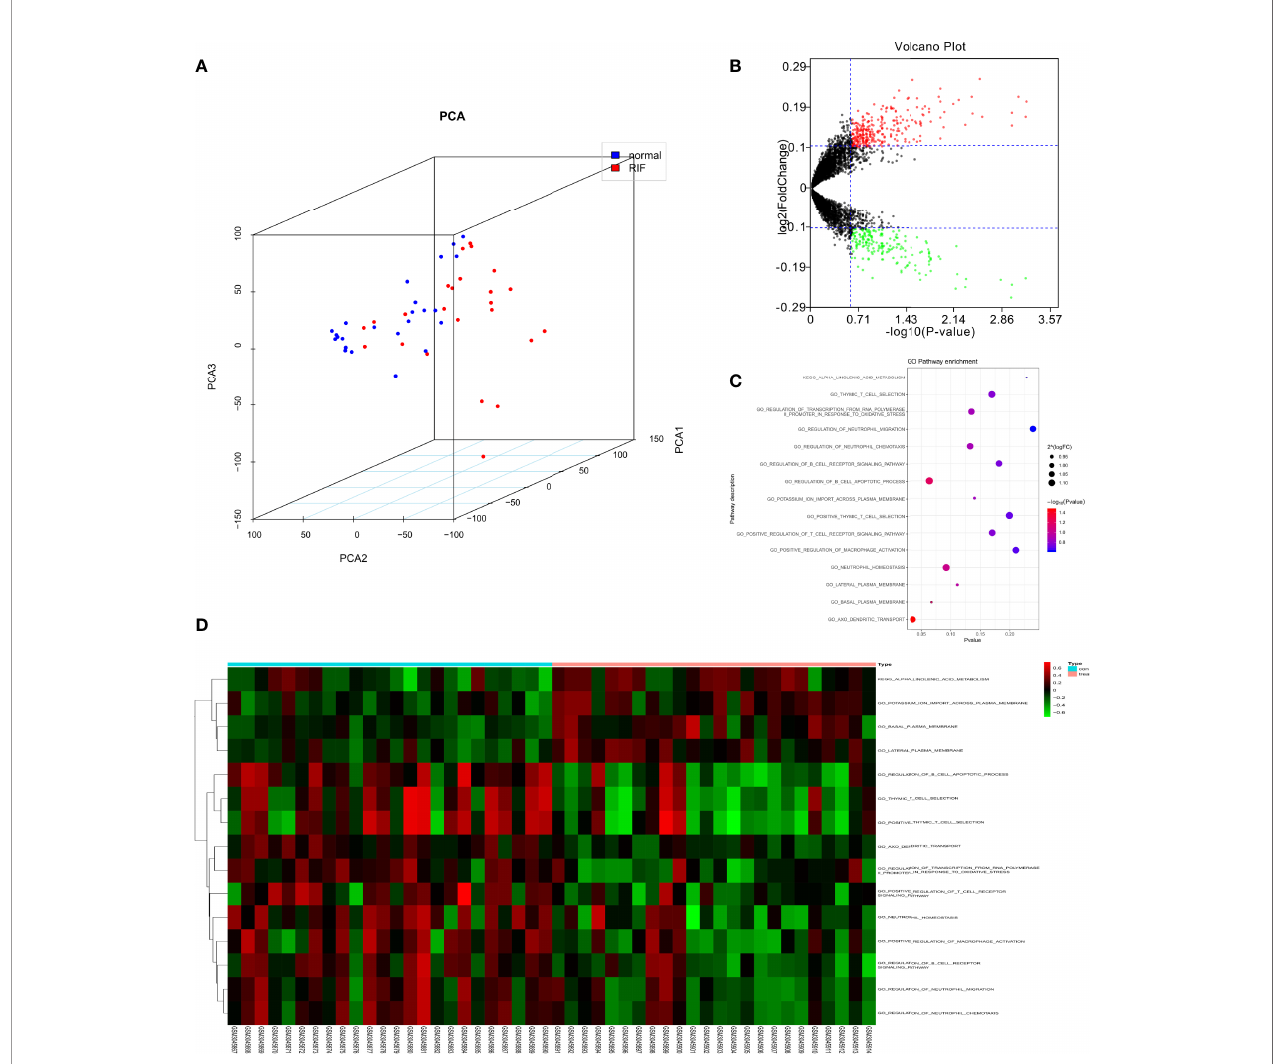
FIGURE 2 | GSVA analysis displaying immune related pathway differences. (A) Principal components analysis of lncRNAs between normal and recurrent implantation failure (RIF) sample. (B) Volcano plot showed the differences in pathway activities scored by GSVA between normal and RIF sample. Differences in pathway activities scored by GSVA between normal and RIF sample. (C) Bubble plot showed the analysis result. (D) Heatmap exhibited the differences of the